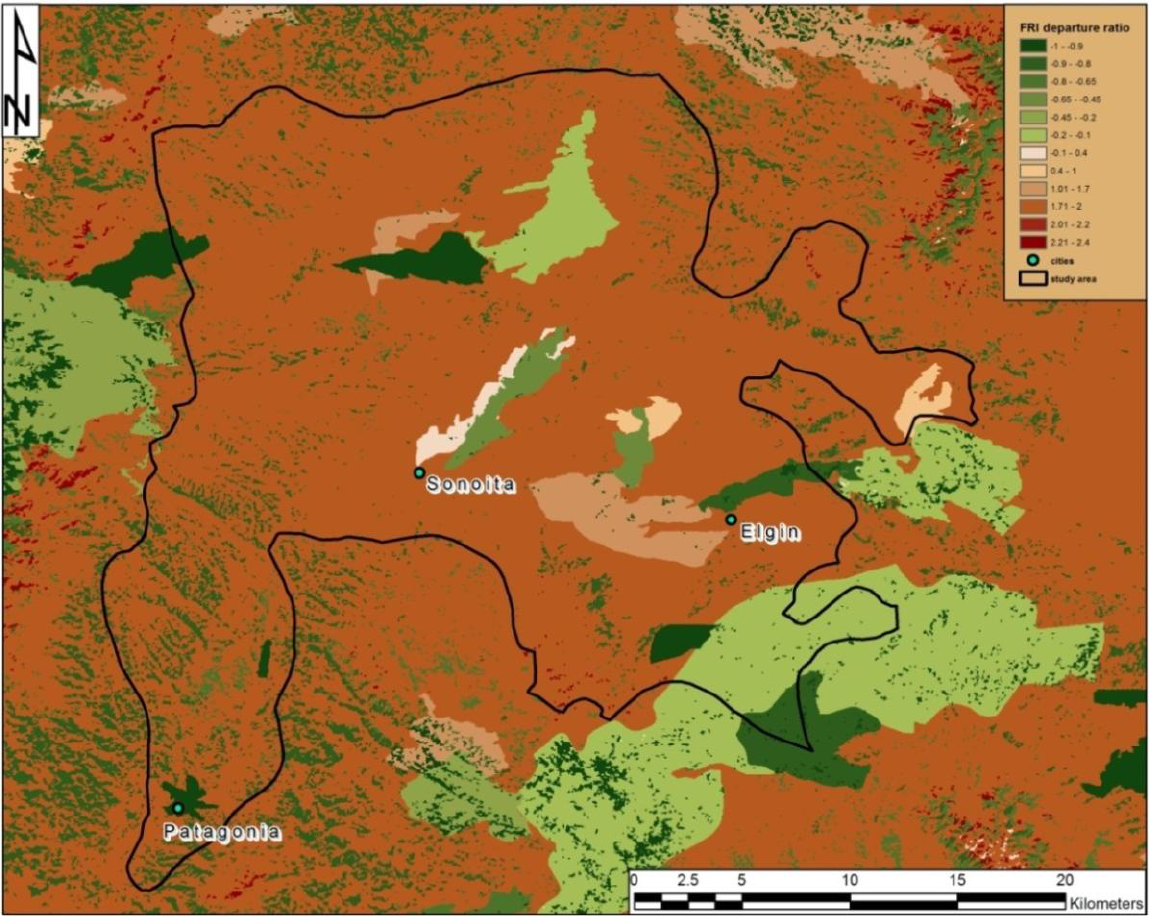
Figure 2. Fire Return Interval Departures (FRID) values for the Sonoita Plain, Arizona. Green represents low risk of fire, while reds and browns represent moderate to high